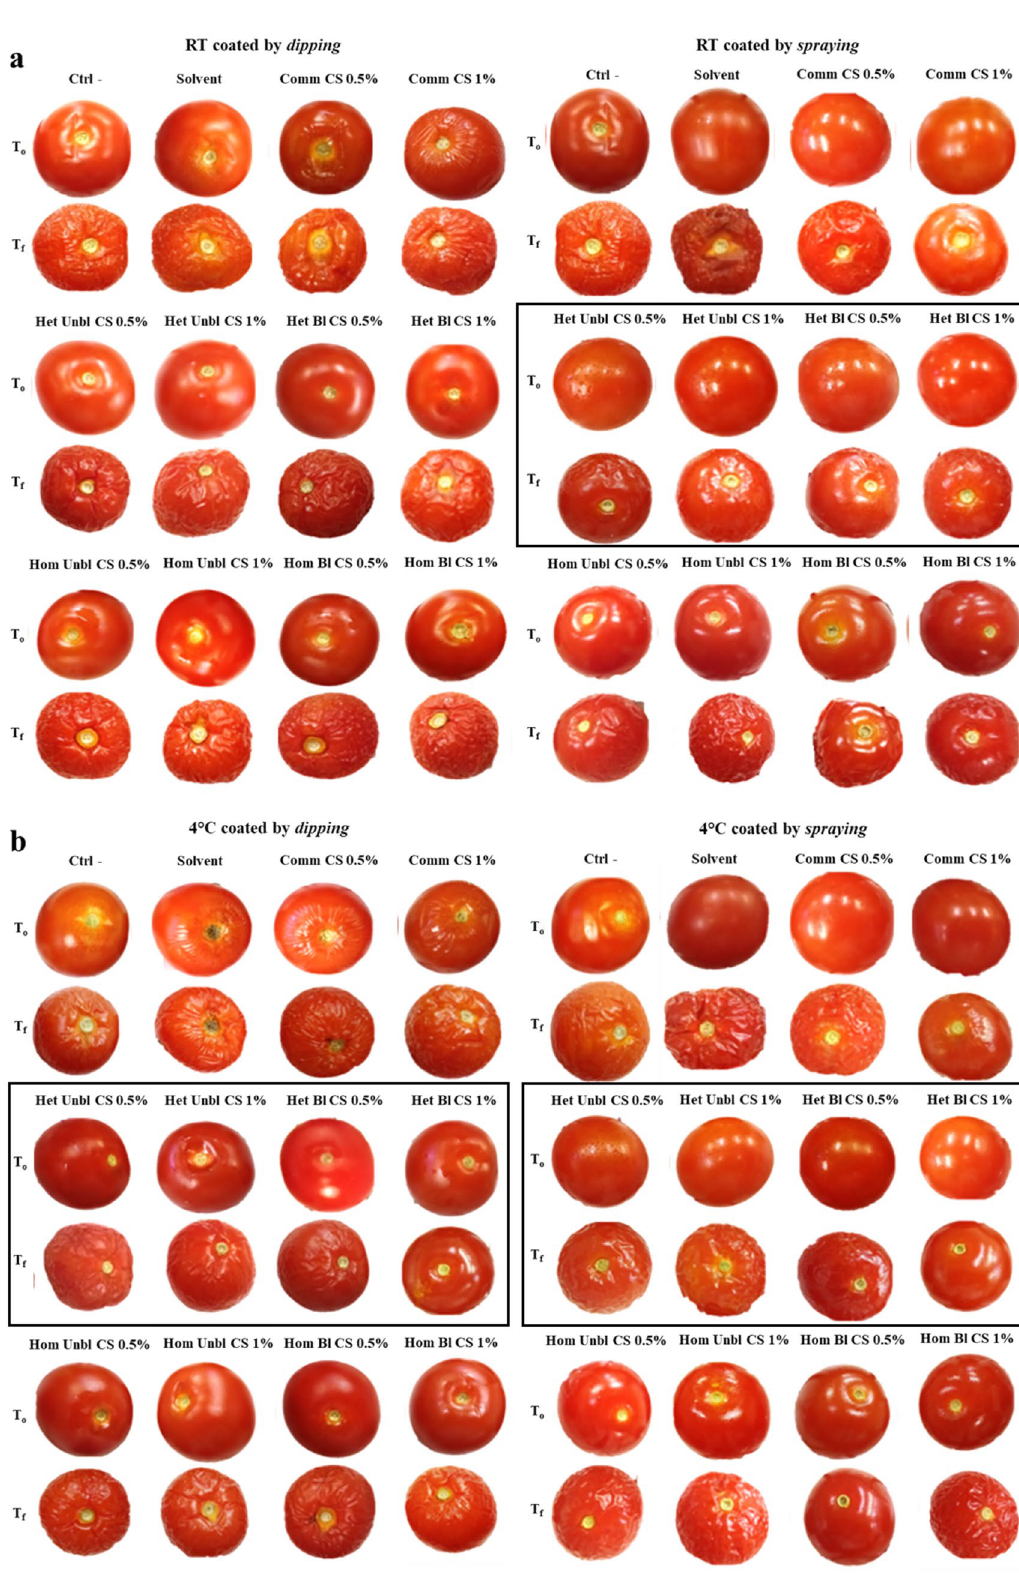
Figure 1. Pictures of tomatoes coated by dipping and spraying at the beginning (T 0 ) and after 30 days (T f ) of storage period at ( a ) room temperature (RT) and ( b ) 4 °C. Treatments that gave the best results are in black frames. Treatments: untreated fruits (Ctrl-), solvent, coating with 0.5 and 1% of commercial chitosan (Comm CS), heterogeneous unbleached (Het Unbl CS), heterogeneous bleached (Het Bl CS), homogeneous unbleached (Hom Unbl CS), homogeneous bleached (Hom Bl CS) chitosan from H. illucens pupal